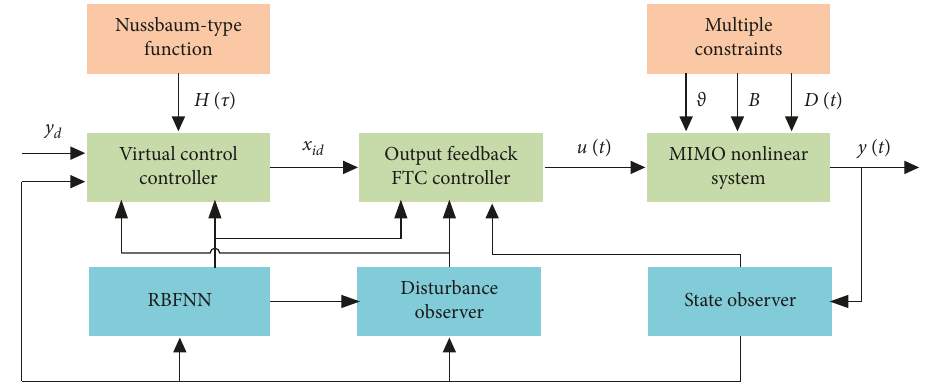
Figure 1: Block diagram of the proposed control